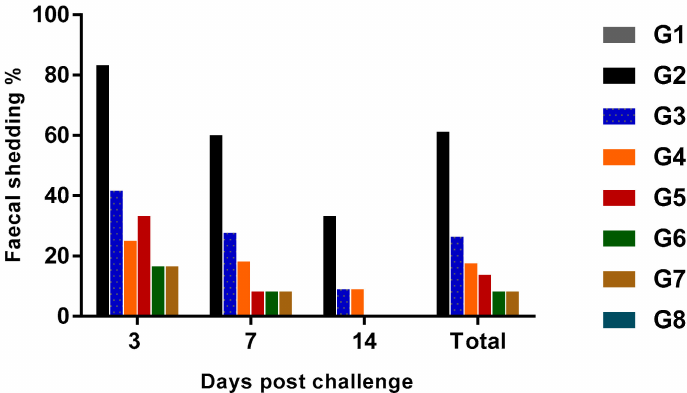
Figure 2. The fecal shedding rate (%) of SE in experimentally challenged groups ( n =